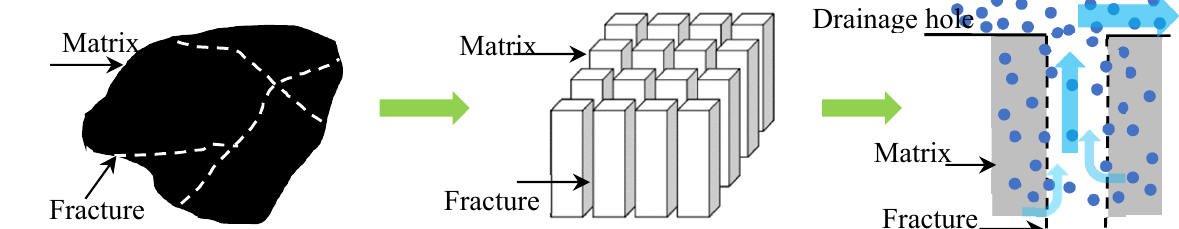
Figure 3. Illustration of the series methane flow in the dual-pore coal.